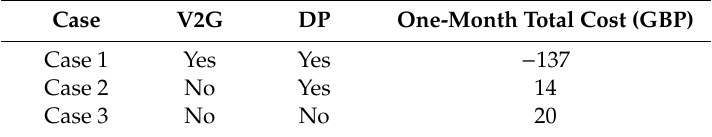
Table 7. Charging cost comparison for di ff erent charging system